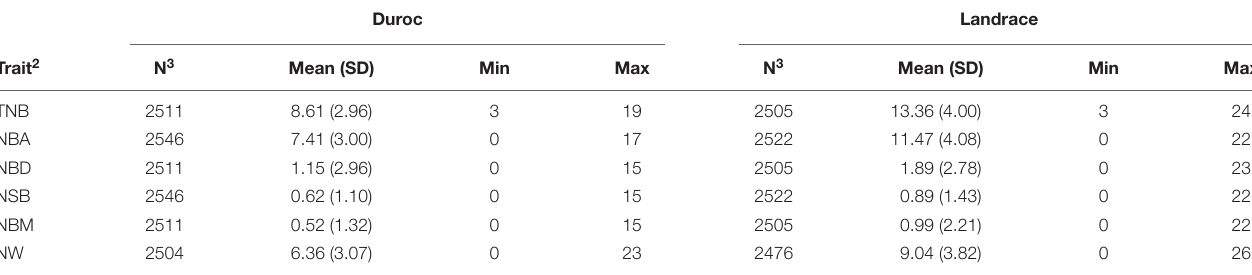
TABLE 1 | Summary statistics of reproductive traits 1 by breed.